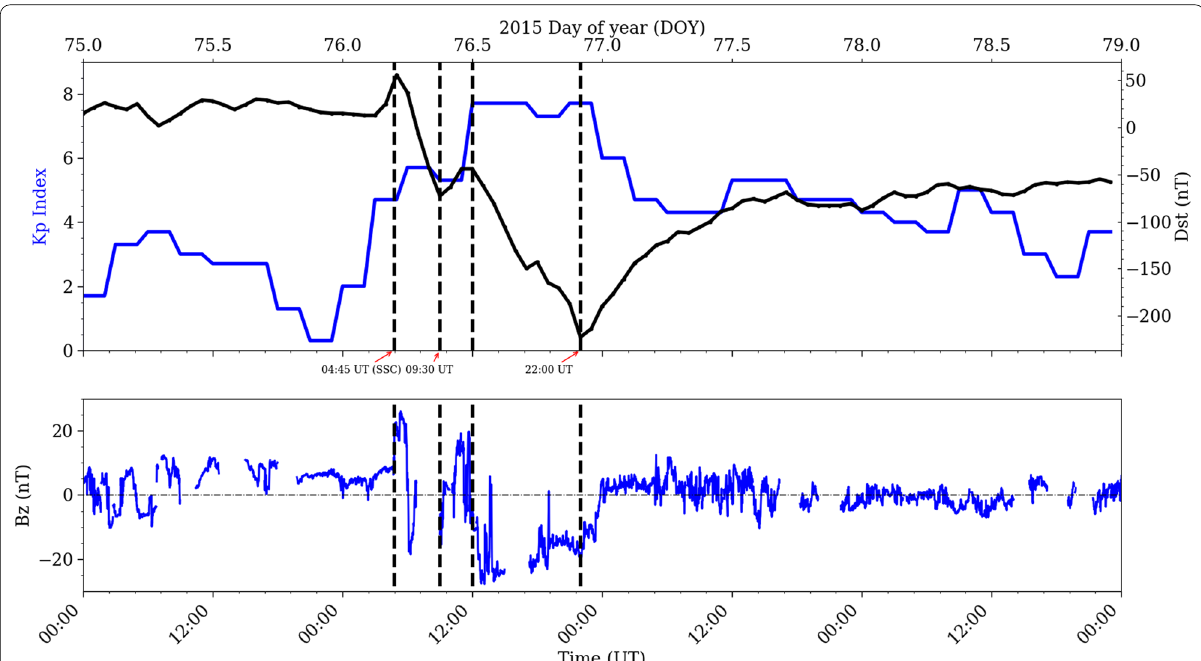
Fig. 3 (Top) Variation of Kp and Dst indices during the 2015 St. Patrick’s day geomagnetic storm. (Bottom) The interplanetary magnetic field (IMF) Bz component variation during the same period. Tick labels on top and bottom represent day of the year (DOY) and time in UT (~ LT-9 h), respectively. The sudden storm commencement (SSC) occurred at ~ 04:45 on DOY 076. The main phase (MP) of the storm started at ~ 06:30 UT and continued until ~ 22:00 UT when Dst hit a minimum ~ 223 nT. During the MP the Kp rose to a maximum of ~ 8. The recovery phase − continued through the following